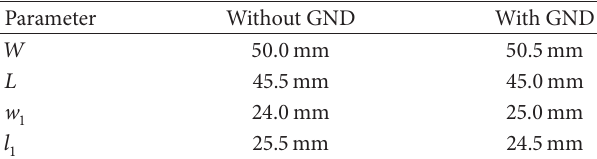
Table 1: The structural